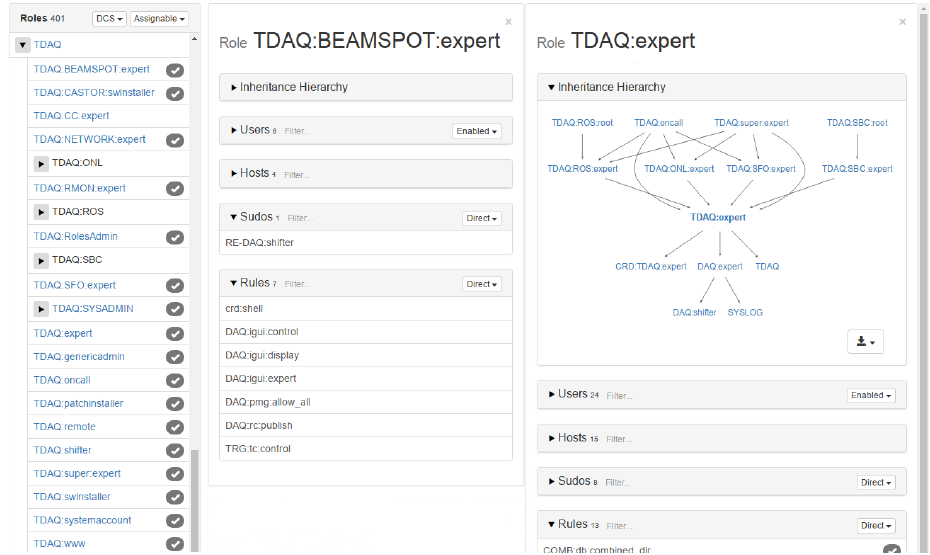
Figure 3. The roles client